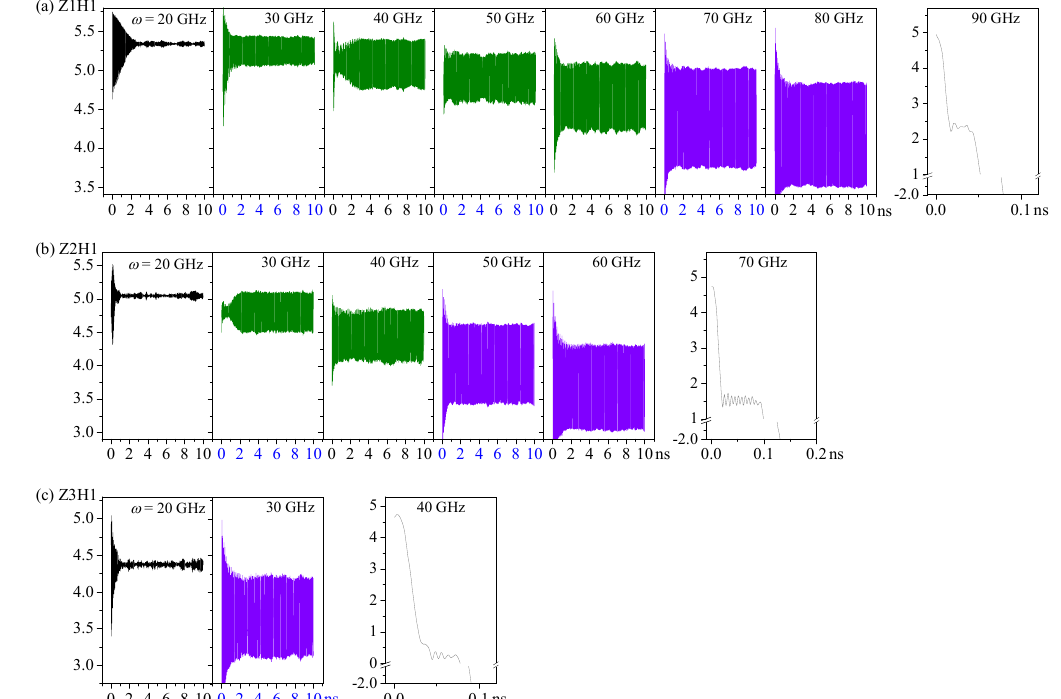
Figure 9. Axial motions of the R-rotor connected with the HDPs with different lengths at 8 K: ( a ) Z1H1 HDP, ( b ) Z2H1 HDP, and ( c ) Z3H1 HDP.